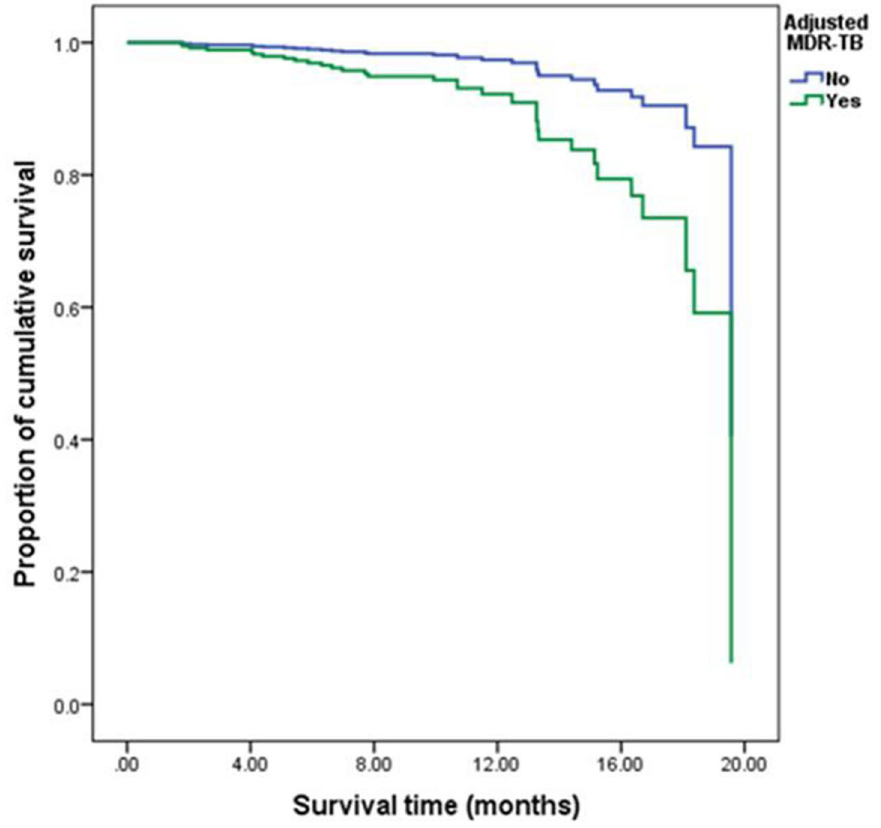
Fig 3. Comparison of cumulative survival function of patients with MDR-TB and patients with non-drug- resistant tuberculosis after controlling other covariables including overcrowding, occupation and smoking.